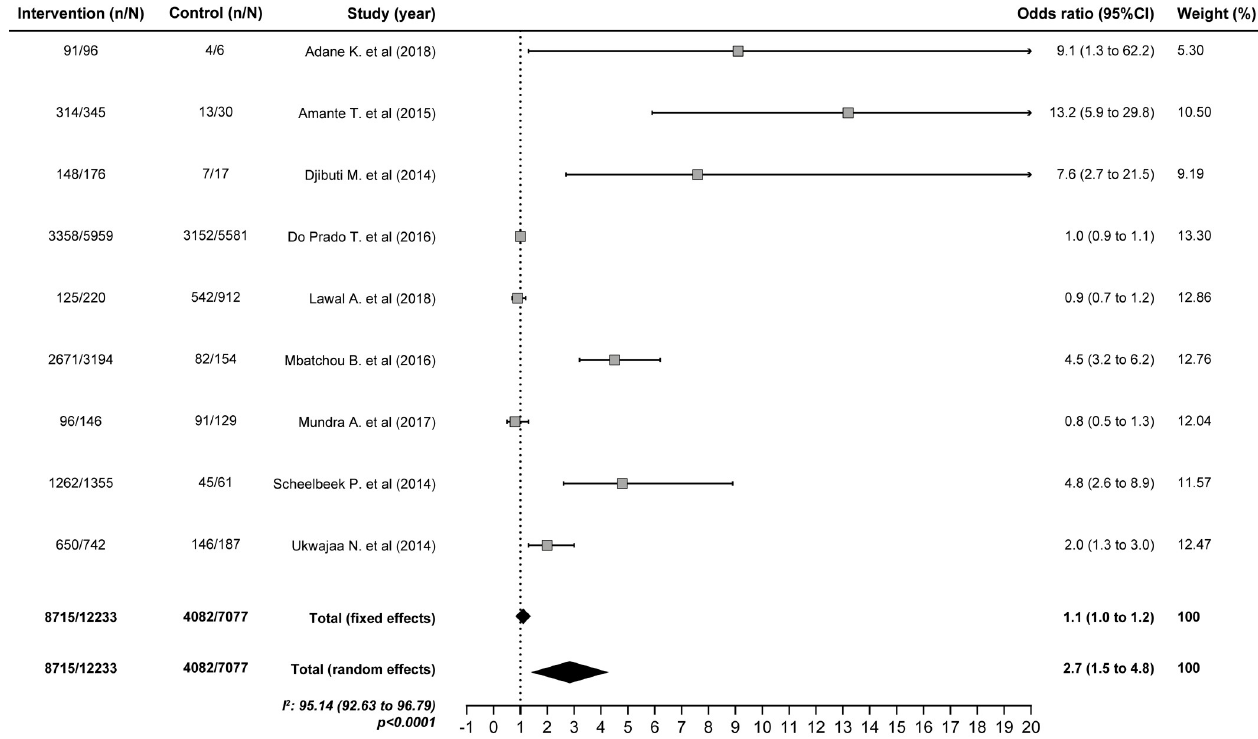
Fig 3. Pooled estimate to negative smear in the 2nd month as a factors predictive of favorable outcomes of tuberculosis treatment.